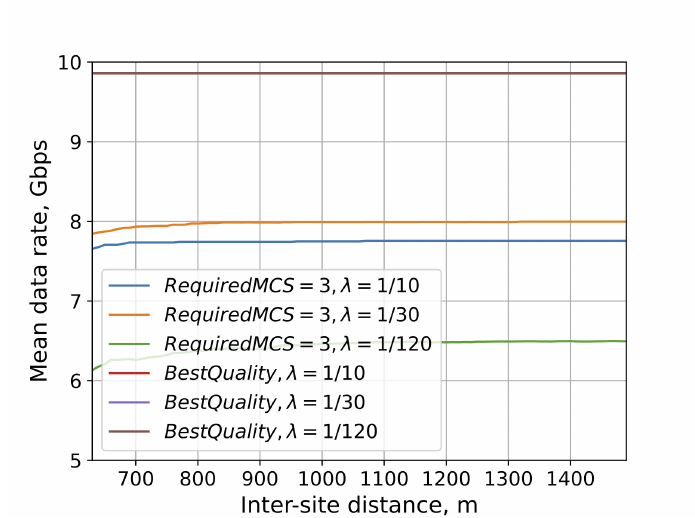
Figure 9. Data rate as a function of vehicles density and last hop selection strategies.